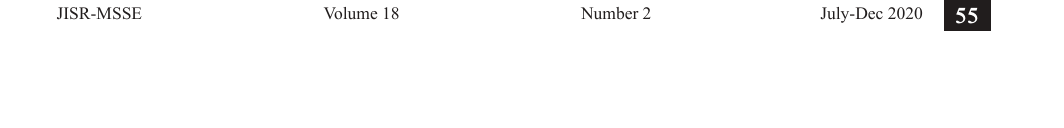
Figure 4: Quadratic Fit of Real Exchange Rate and Tourism Demand (Source: Author’s computation,